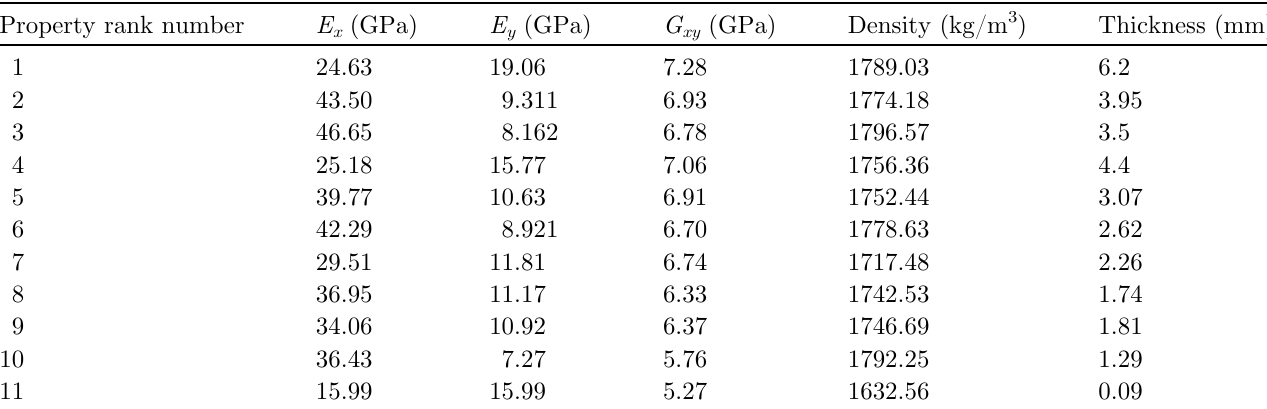
Table 1. Material properties engineering data and ranking. Property rank